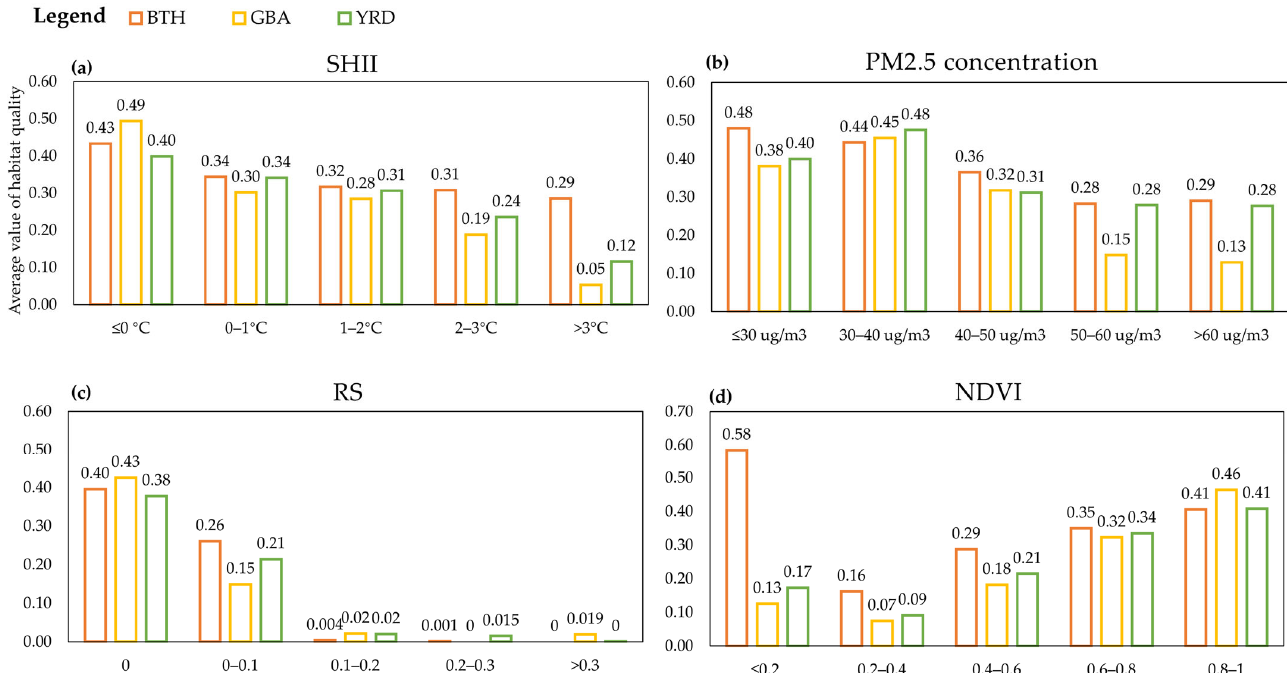
Figure 13. The performances of the graded environmental situations under the risk detector: ( a ) SHII, ( b ) PM2.5, ( c ) RS, and ( d ) NDVI.